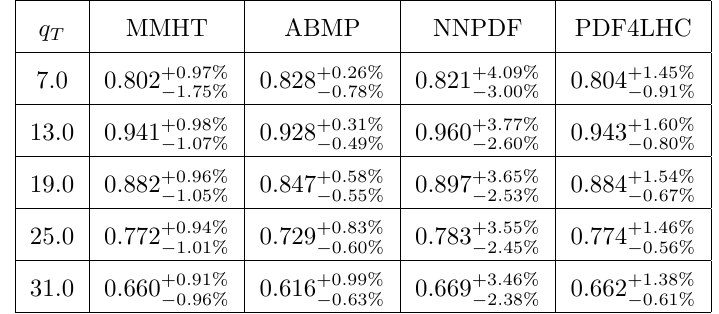
Table 1 . q T distributions at NNLO A +NNLL using di(cid:11)erent PDF sets along with percentage